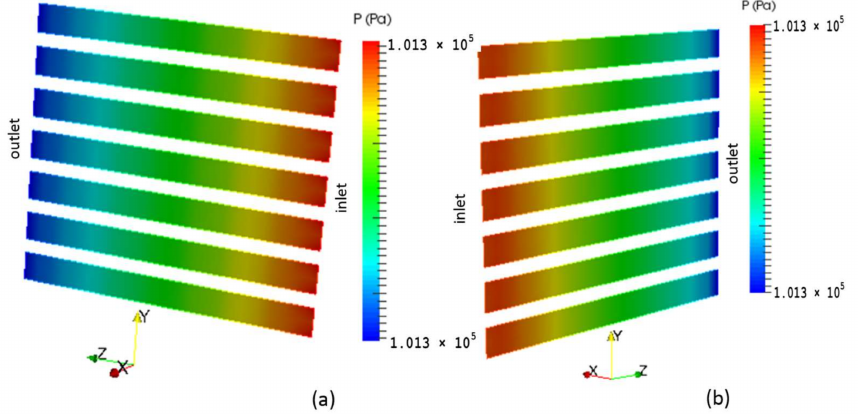
Figure 7. Pressure distribution in the gas flow channels: ( a ) Fuel; ( b ) Air.